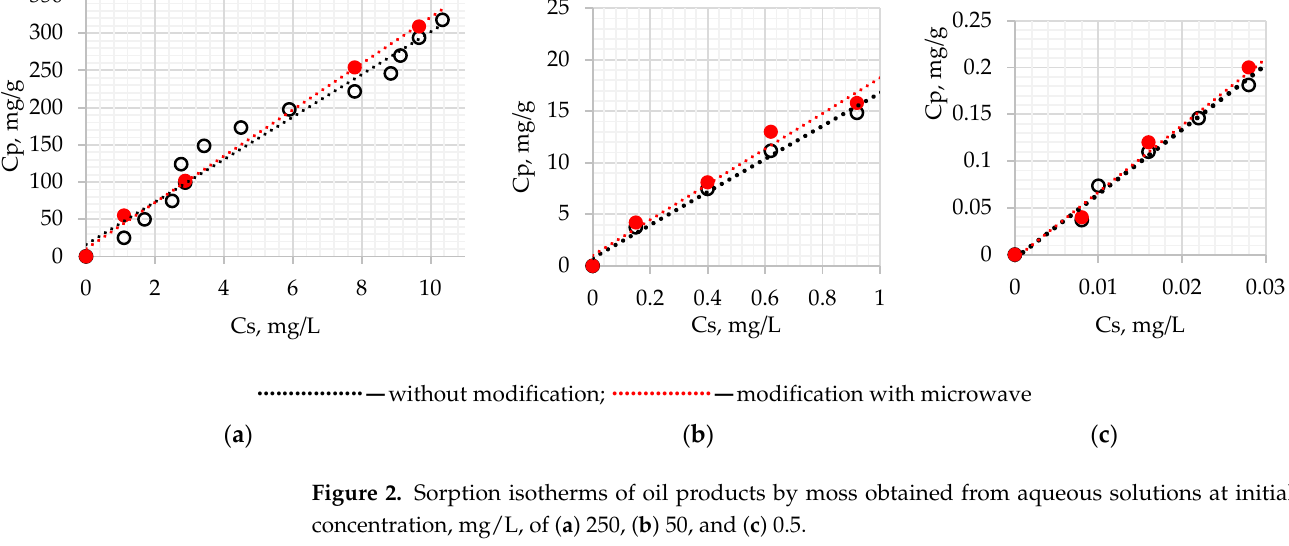
Figure 2. Sorption isotherms of oil products by moss obtained from aqueous solutions at initial concentration, mg/L, of ( a ) 250, ( b ) 50, and ( c ) 0.5.